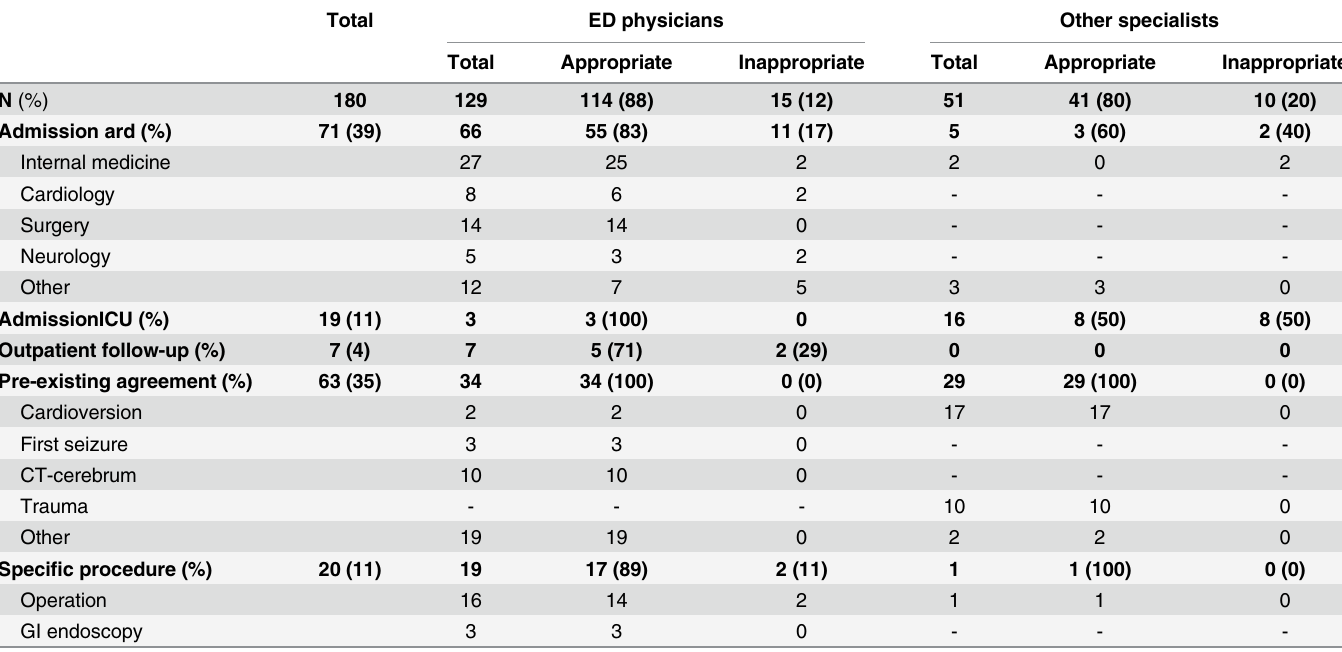
Table 2. Appropriateness of mandatory